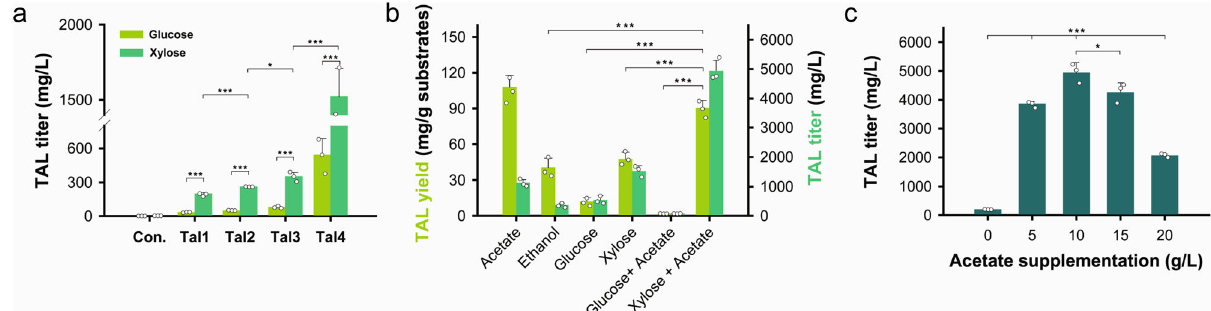
Fig. 4 Effect of 2PS gene copy numbers and substrates on TAL production. a Improved production of TAL by increasing the copy numbers of 2PS genes (*** P < 0.001 Tal1 xylose vs glucose, *** P < 0.001 Tal2 xylose vs glucose, *** P < 0.001 Tal3 xylose vs glucose, *** P = 0.002 Tal4 xylose vs glucose, *** P < 0.001 Tal2 vs Tal1 in xylose, * P = 0.014 Tal3 vs Tal2 in xylose, *** P < 0.001 Tal4 vs Tal3 in xylose). b Yield of TAL from different single and mixed substrates by the Tal4 strain. Calculated from cultures of Tal4 strain with 10 g/L ethanol, 10 g/L acetate, 40 g/L glucose, 40 g/L xylose, 40 g/L glucose + 10 g/L acetate and 40 g/L xylose + 10 g/L acetate, respectively (TAL Yield: *** P < 0.001 Xylose + Acetate vs Glucose + Acetate, *** P < 0.001 Xylose +